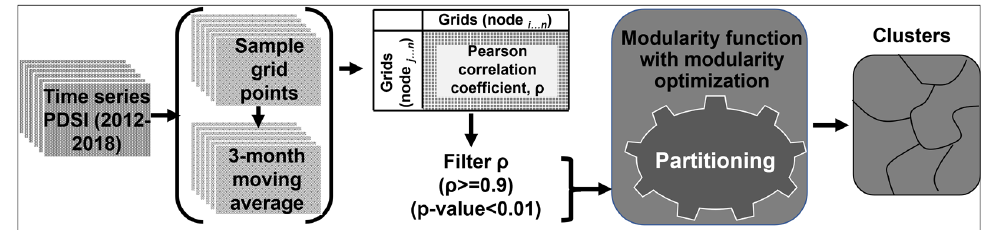
Figure 1. Processing workflow for network analysis clusters partitioning process.